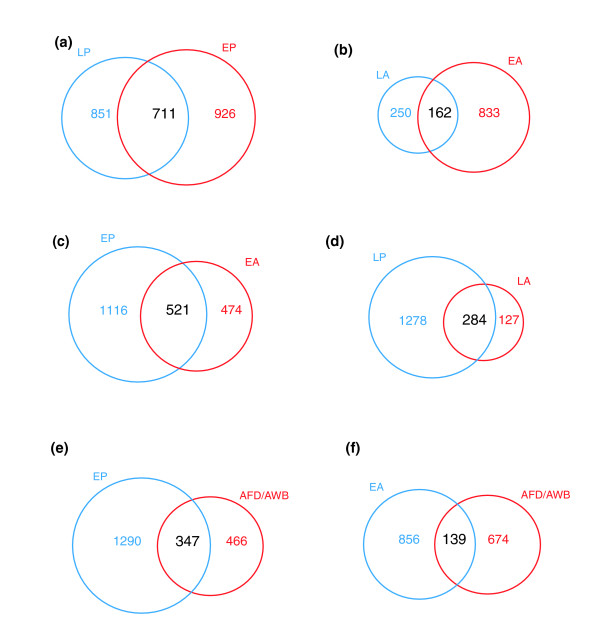
Venn diagrams comparing transcripts from profiled cell types at specific developmental stages. (a) Larval pan-neural (LP) and embryonic pan-neural (EP) datasets are enriched for common transcripts, but also contain transcripts exclusive to either developmental stage. (b) Larval A-class (LA) and embryonic A-class (EA) identify 162 shared transcripts. Transcripts selectively enriched in either neuron type may contribute to the unique morphologies of DA versus VA motor neurons (Figure 10). (c,d) The depth of the pan-neural datasets (EP, LP) is reflected in the substantial overlap with the A-class motor neuron profiles (EA, LA). Genes exclusively enriched in the EA and LA profiles are indicative of rare transcripts showing neuron specific expression. (e,f) Comparisions of the embryonic neural specific datasets (EP, EA) described in this paper with the embryonic profile of specific thermosensory neurons (AFD and AWB described by Colosimo et al. [8]. The AFD/AWB profile shows greater overlap with the EP dataset (e) than with the EA profile (f). See Additional data files 10 and 11 for lists of genes identified in each comparison.